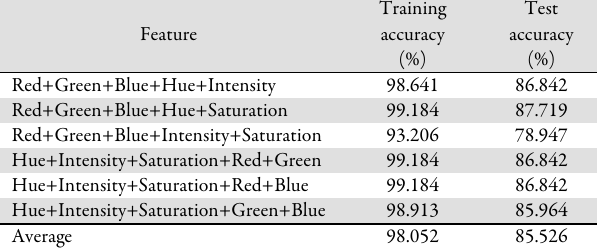
Table 6. Accuracy values using five colour